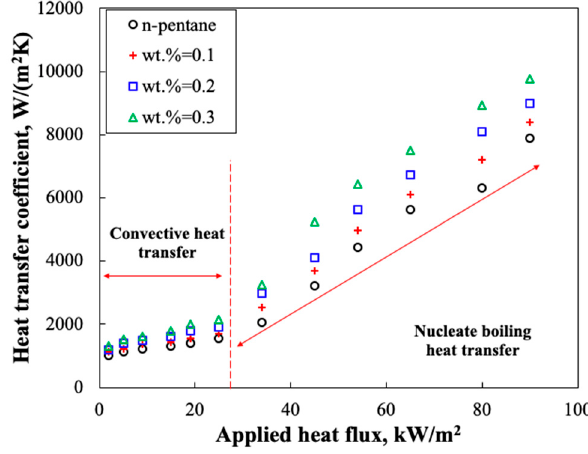
Figure 4. Alteration of the HTC with heat flux for n-pentane and nanofluids.